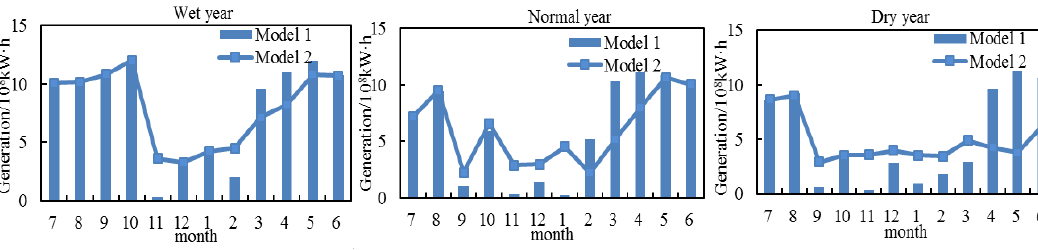
Figure 8. Variation of the monthly generating capacity of Xiaolangdi in each typical year.